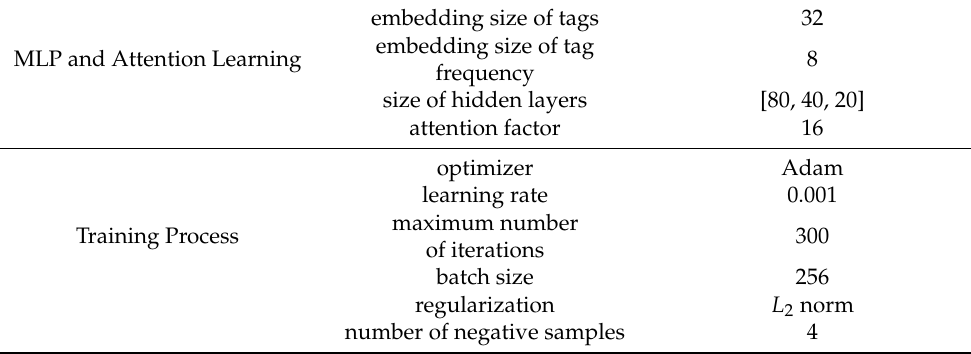
Table 2. Specific parameters of the proposed TRAL used in experiment.